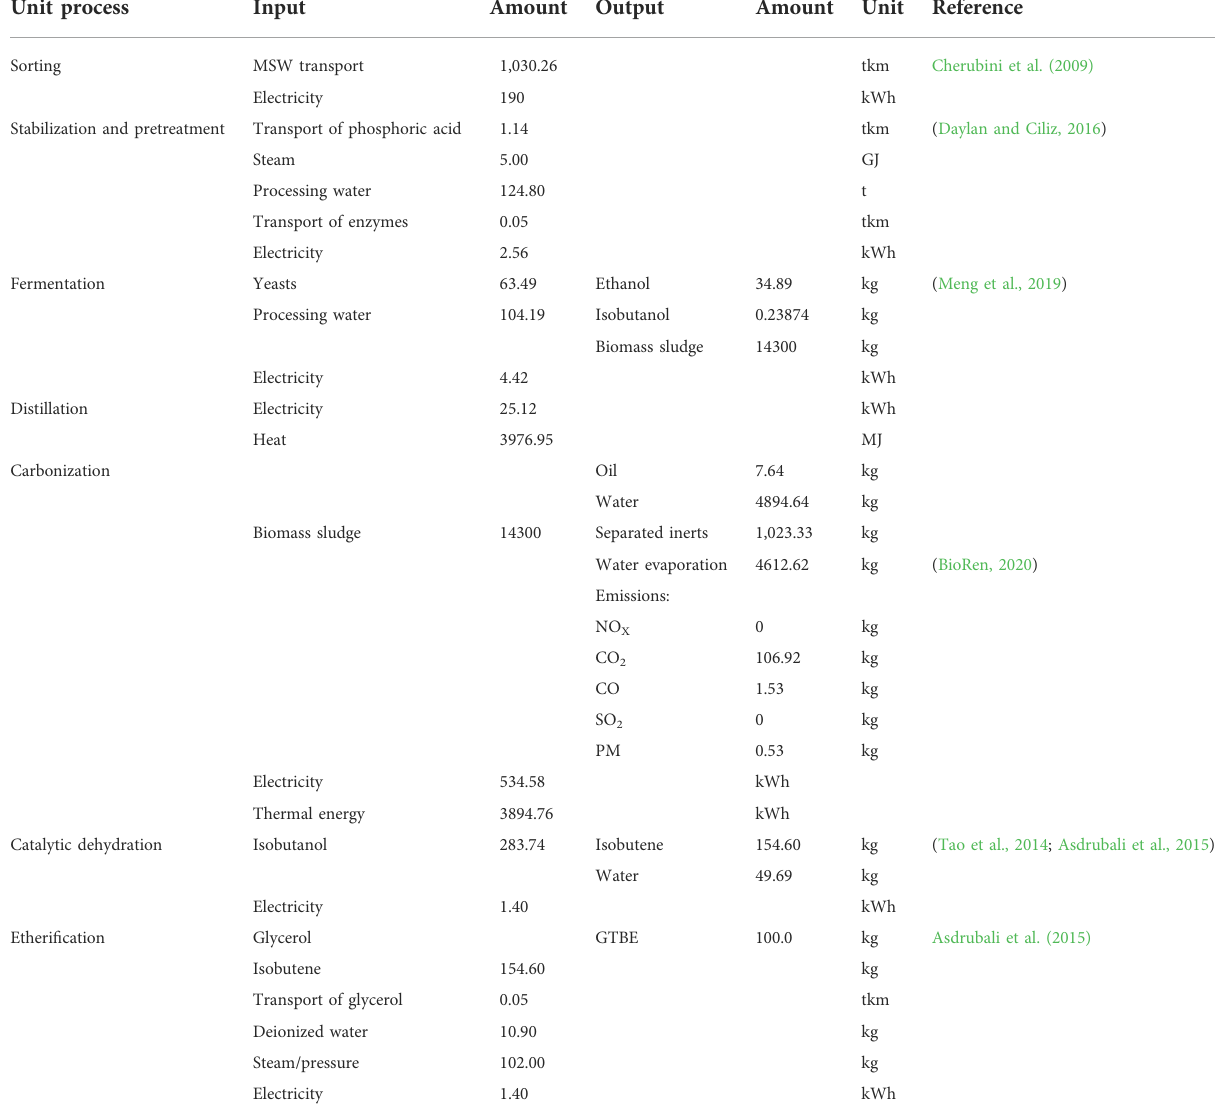
TABLE 3 Amounts of products, and material and energy consumption data of the BioRen